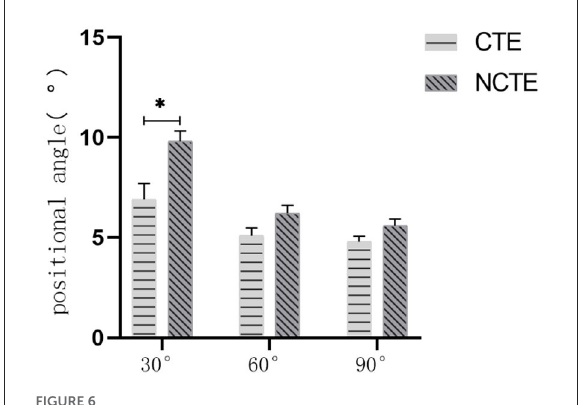
FIGURE6 Proprioception after 2 weeks of treatment: At the end of the second week, the angle of the CTE group was smaller than the control group at 30 ◦ ( P = 0.003). There was no statistically significant difference in the positional angle between the two groups at 60 and 90 ◦ ( P > 0.05). CTE, cognitive therapeutic exercise; NCTE, no cognitive therapeutic exercise. *indicates a significant difference between the two groups when completing the position perception test with a target angle of 30 ◦ .